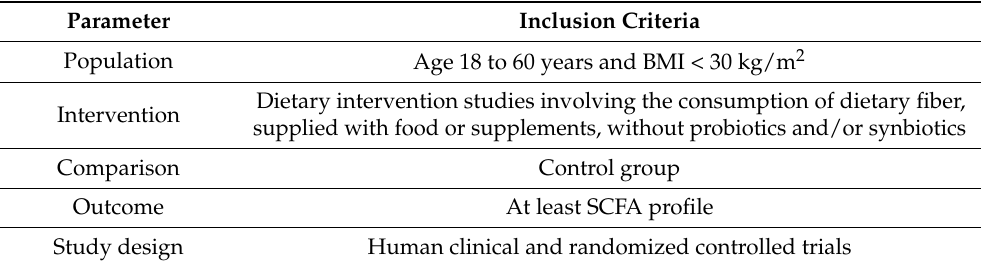
Table 1. PICOS table for inclusion of